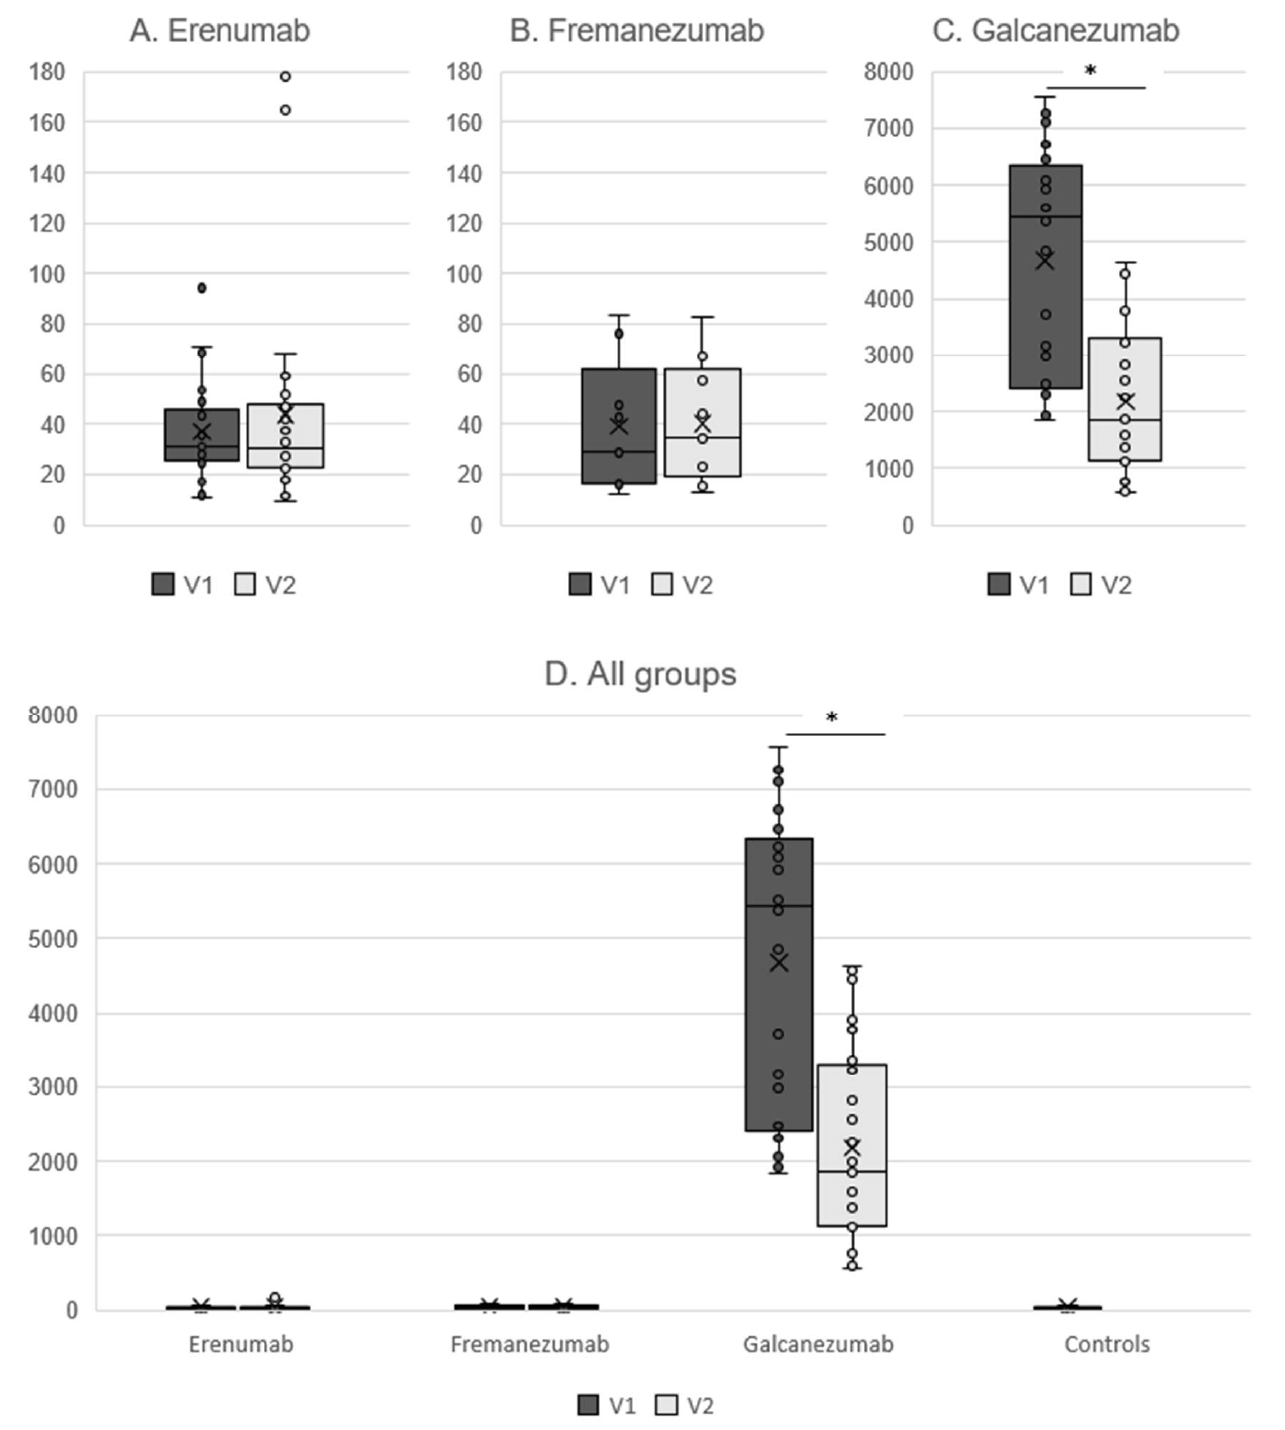
Figure 1. Free CGRP plasma concentrations in pg/mL in patients treated with erenumab ( A ) and fremanezumab ( B ), total CGRP concentrations for galcanezumab ( C ), and comparison between all groups ( D ). V1 = last mAb injection. V2 = 16 weeks after the last mAb injection. * p < 0.001.